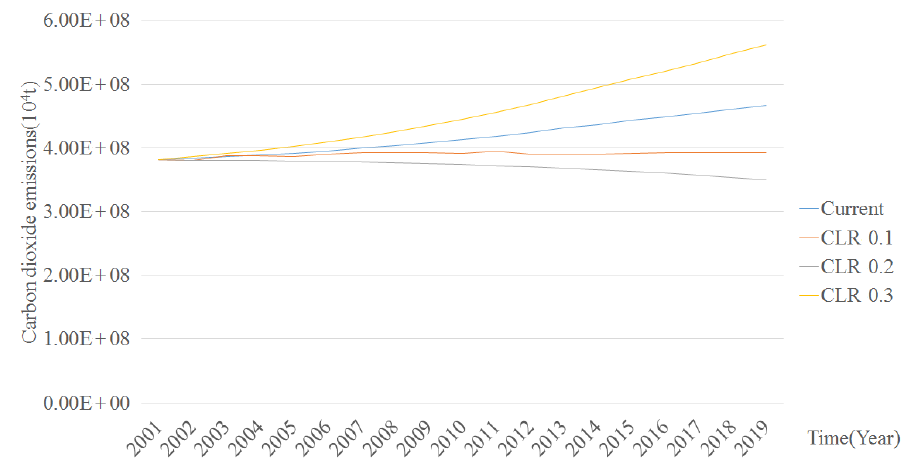
Figure 6. Road-to-rail freight volume demand with different carbon levy rates.